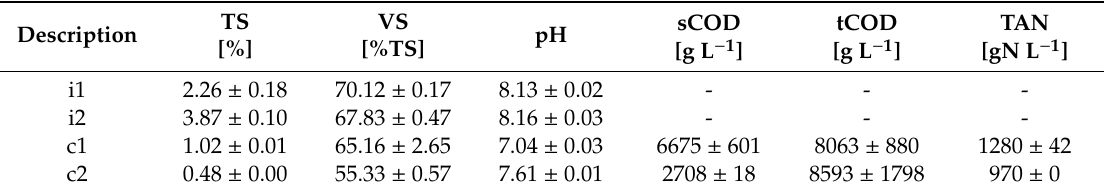
Table 3. Main physico-chemical characteristics of the inoculum and raw SW used for the integrated air stripping and anaerobic digestion (AS and AD) system